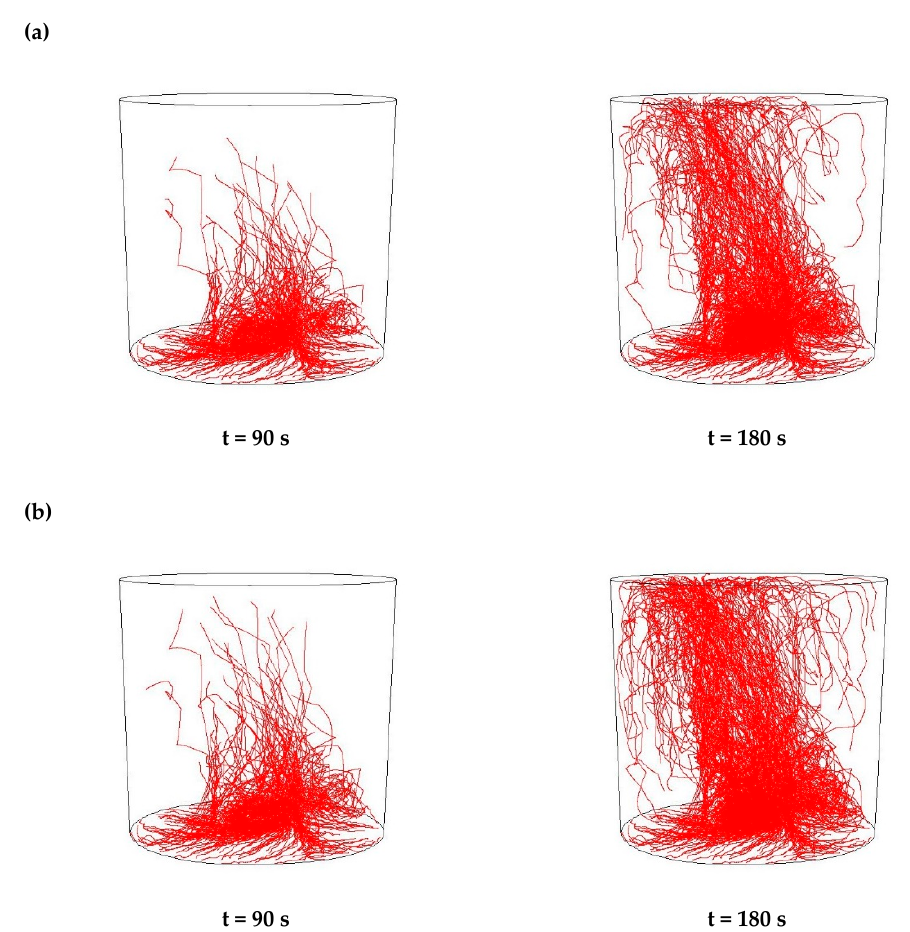
Figure 10. Trajectories of non-metallic MnS inclusions for the case of argon flow of 50 L/min for the particle diameters of ( a ) 18 µm and ( b ) 27 µm in the 18CrNiMo7-6 steel.